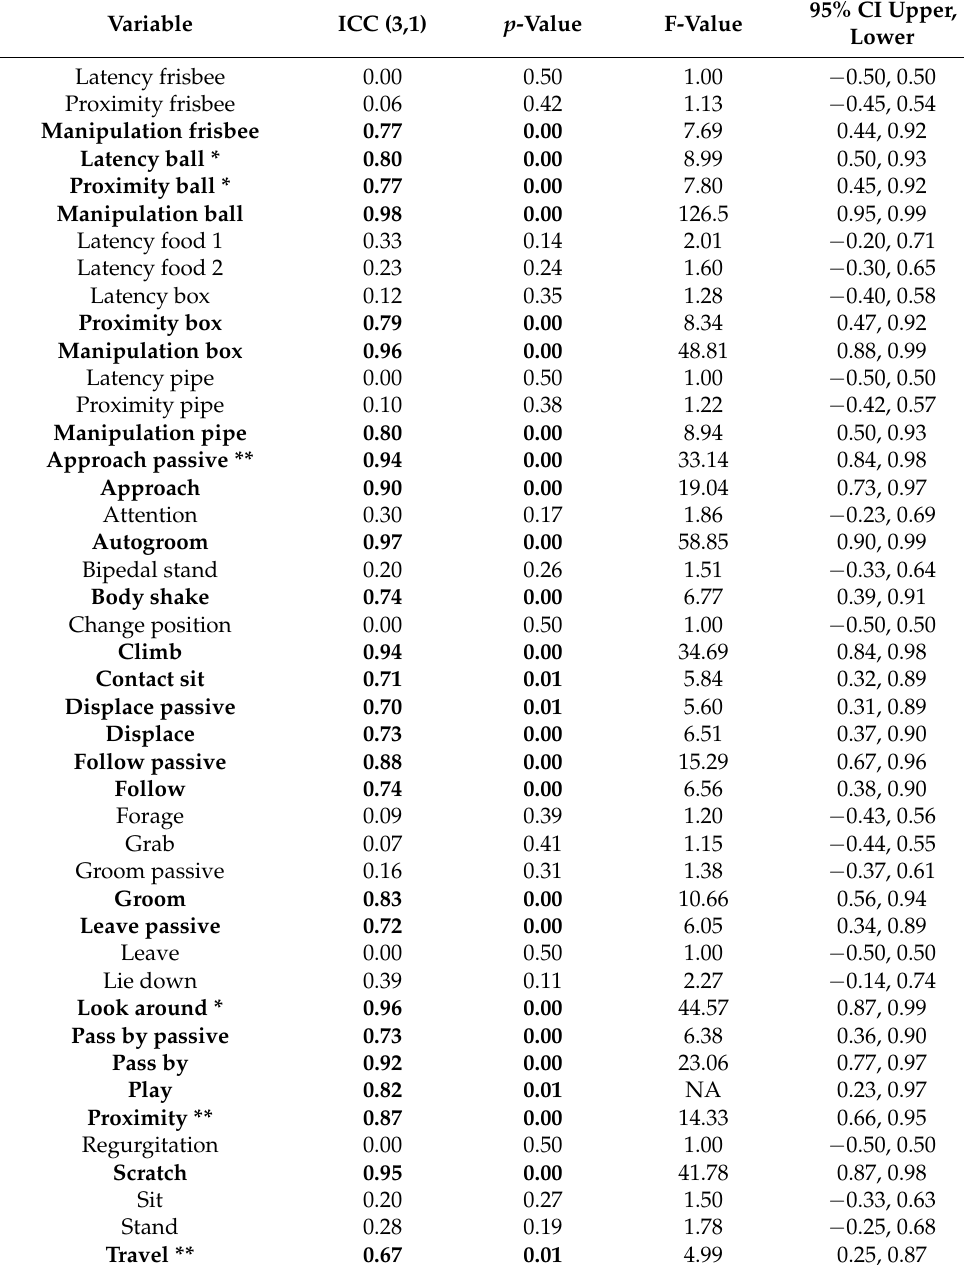
Table 1. Temporal consistency of all variables with the test statistics of the intraclass correlation (ICC 3,1)